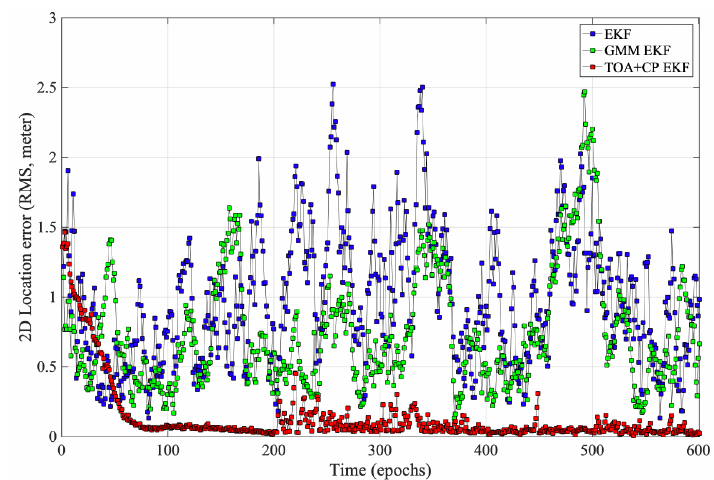
Figure 6. Statistic of mobile positioning error.